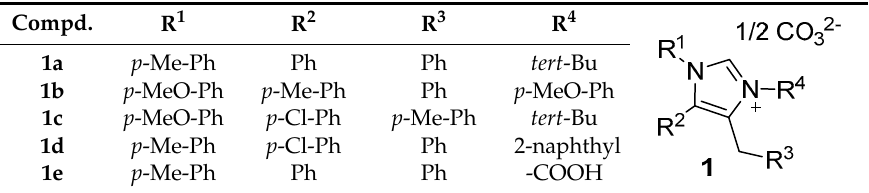
Table 1. Structural description of imidazolium salts 1 .